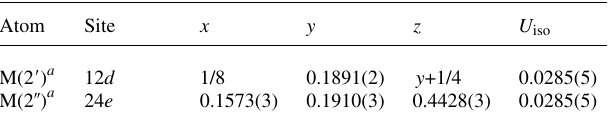
Table 2. Atomic coordinates and displacement parameters (in Å 2 ) . Table 1. Data collection and